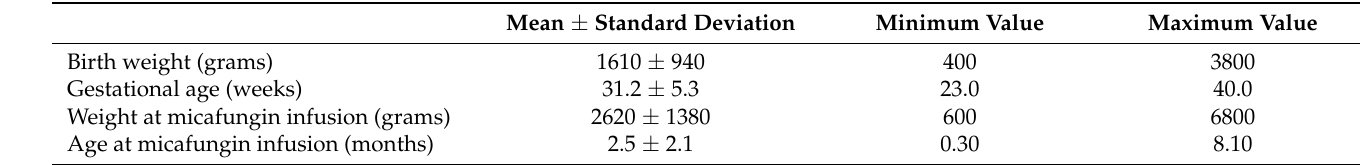
Table 1. Demographics of included